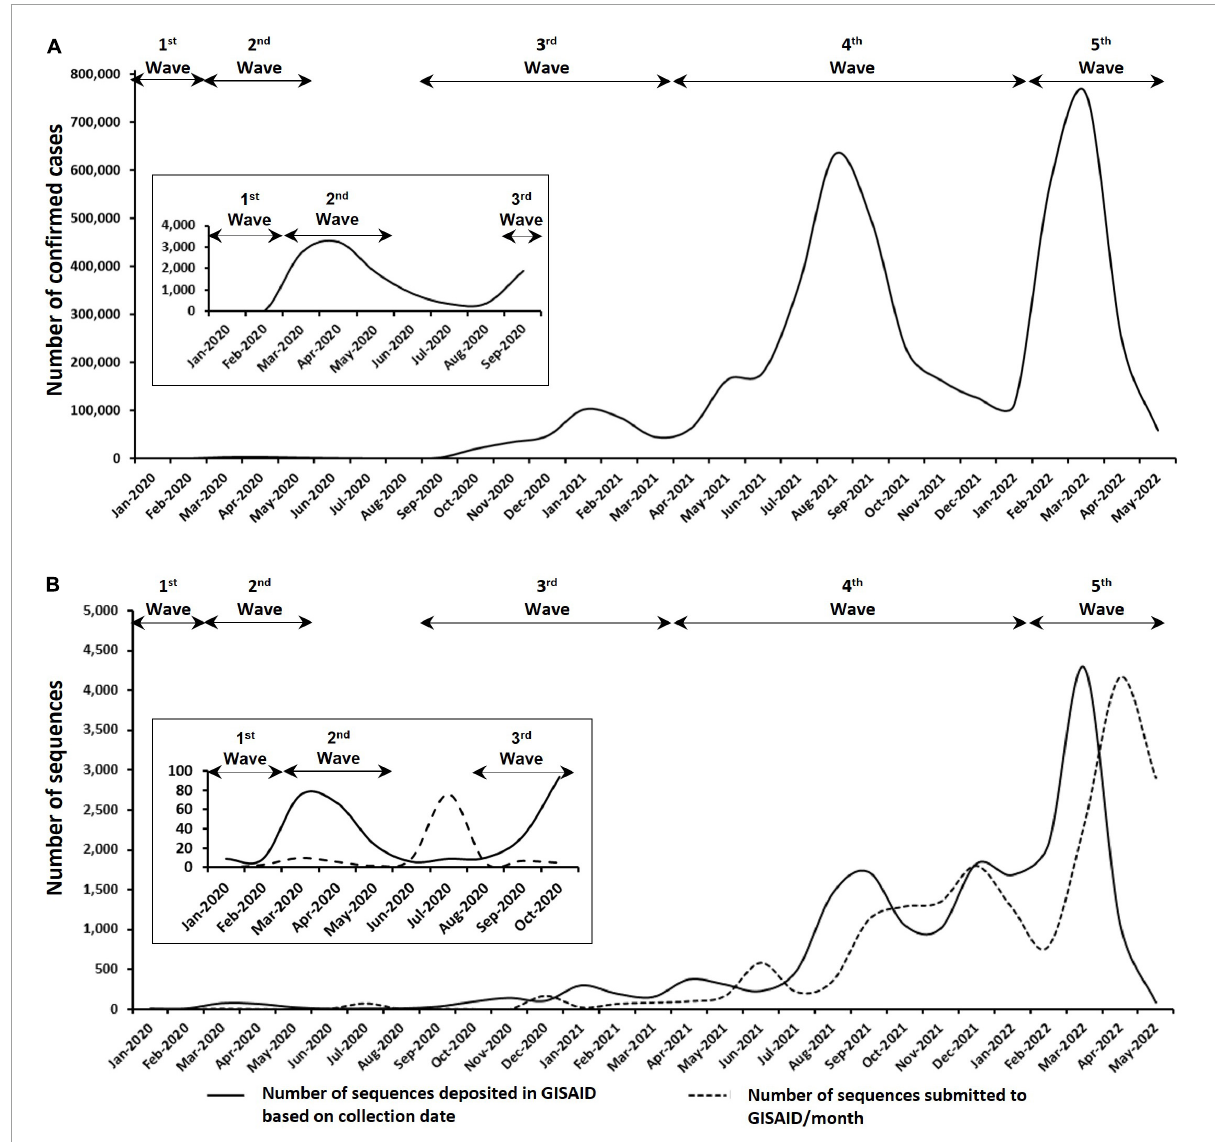
FIGURE1 Epidemiology of COVID-19 in Malaysia as of 31 May 2022. (A) Number of confirmed COVID-19 cases in Malaysia. (B) Number of SARS-CoV-2 genomic sequences submitted to GISAID based on the collection date of samples and submission date. Insets are enlarged figure of the first few months of the COVID-19 pandemic in